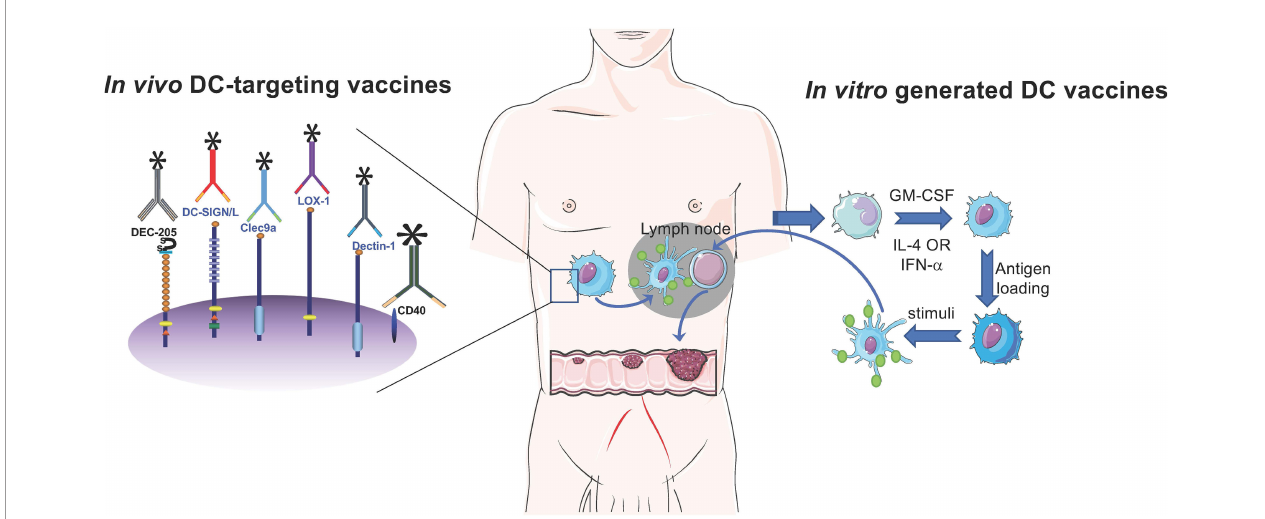
FIGURE 1 | Schematic overview of DC-based CRC vaccines. DC-based vaccines consist of two main approaches: in vitro generated DC vaccines and in vivo DC- targeting vaccines. In vivo DC targeting is a vaccine approach to deliver antigens directly to DCs in vivo using chimeric targets composed of an anti-DC receptor antibody and an antigen. In vitro -generated vaccines often used monocyte-derived DCs. Brie fl y, DCs are generated by culture of monocytes in the presence of GM- CSF and IL-4 (or IFN- a ), which are then loaded with tumor-associated antigens (TAAs). After maturation, TAA-loaded DCs are injected into CRC